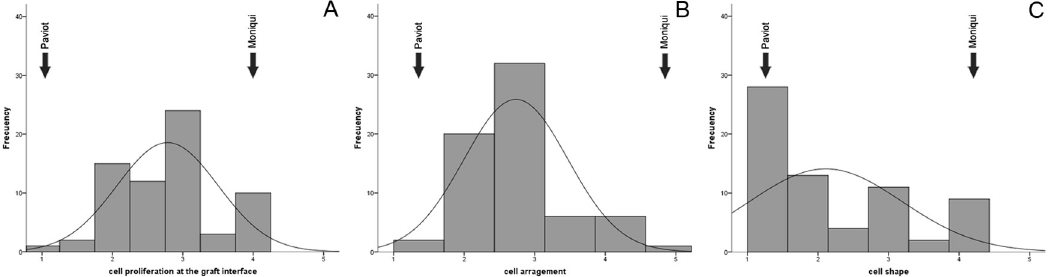
Fig 4. Distribution of proportion of 65 seedlings of ‘Moniqui’ × ‘Paviot’ F 1 apricot progeny grafted on ‘Marianna 2624’ based on cytomorphological observations. Cell proliferation at the graft interface (A), cell arrangement (B) and cell shape (C) one month after grafting.